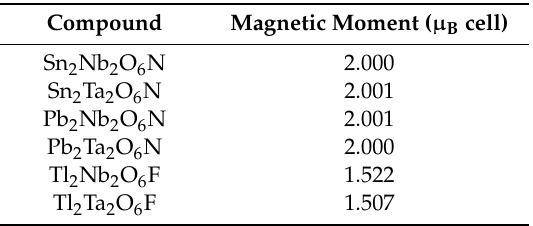
Table 1. Magnetic moment per primitive unit cell (i.e., two formula units) obtained by our first-principles calculation. We show the results for GGA. The lattice constant a was set to the value of the “mother compound”. For example, we used the a of Sn 2 Nb 2 O 7 for Sn 2 Nb 2 O 6 N.